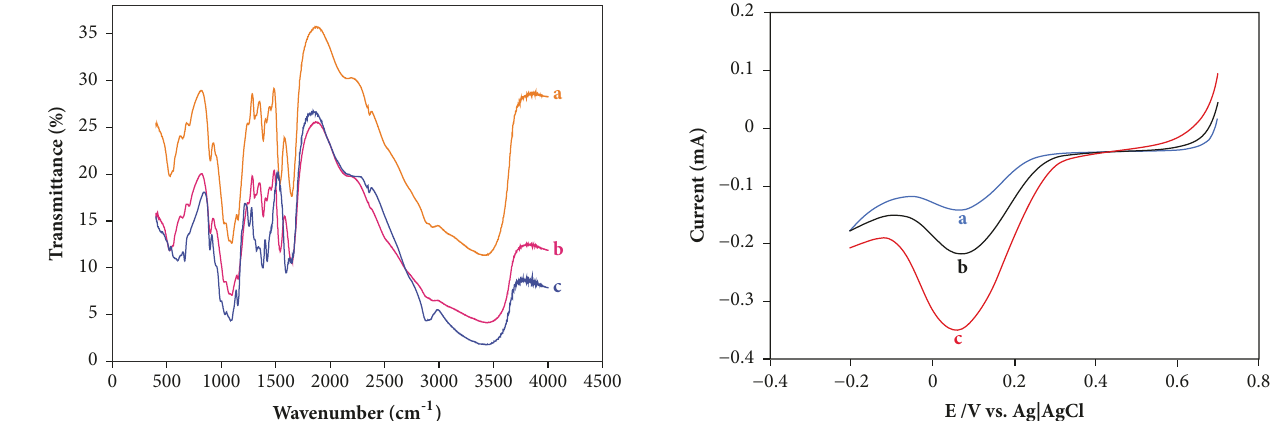
Figure 12: The current density versus elapsed time for the stability examination of the self-pumping